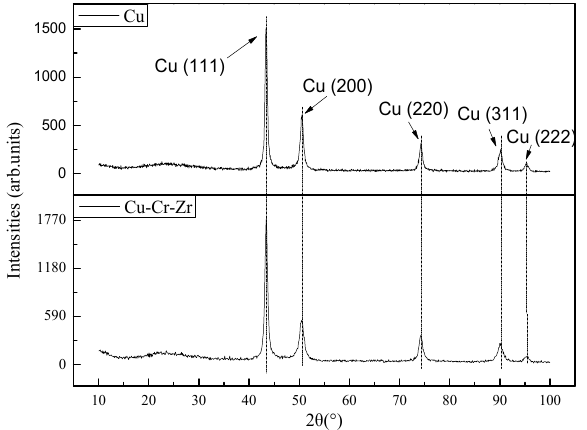
Figure 6. The XRD of Cu-Cr-Zr and pure Cu thin-film samples.